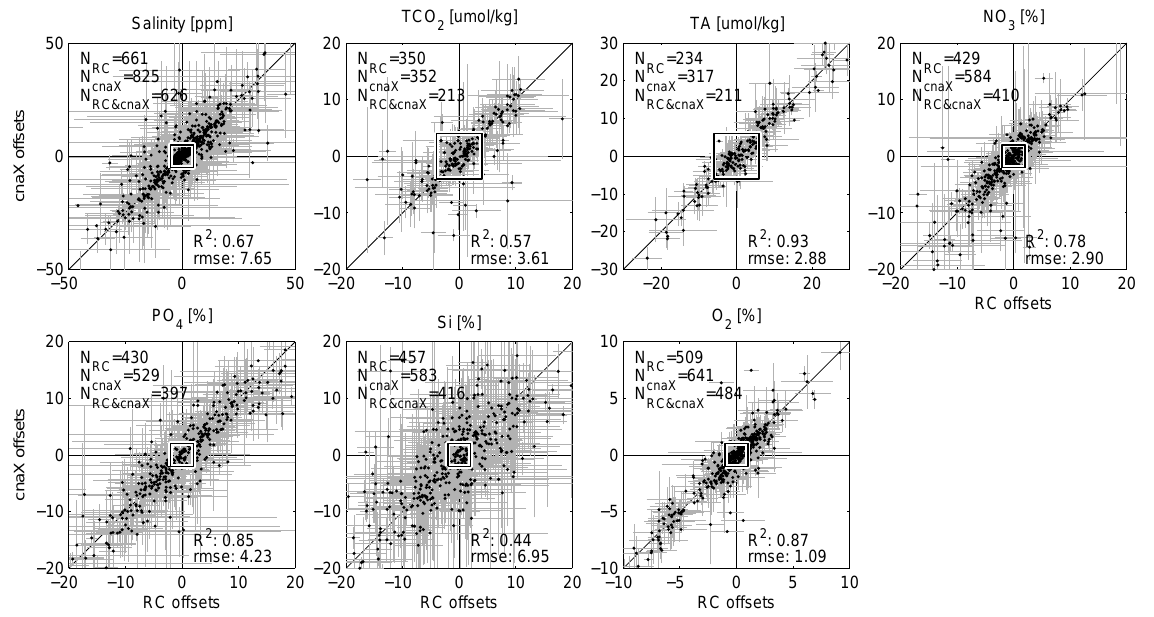
Figure 6. Figure comparing o ff sets determined by the cnaX method and the Running-Cluster (RC) method for the SO and ATL areas (black dots with gray error bars). The square in the middle of the figures indicate the minimum adjustment that were applied to the data. The numbers in the upper left corner states the number of crossover that the di ff erent methods found; the numbers in the lower right corner states the R 2 value of the linear fit and and the rmse of the di ff erence between the methods. The methods are generally in good agreement, with the exception for silicate, where the standard deviation of di ff erences between the two methods is around 7%. See text for discussion.